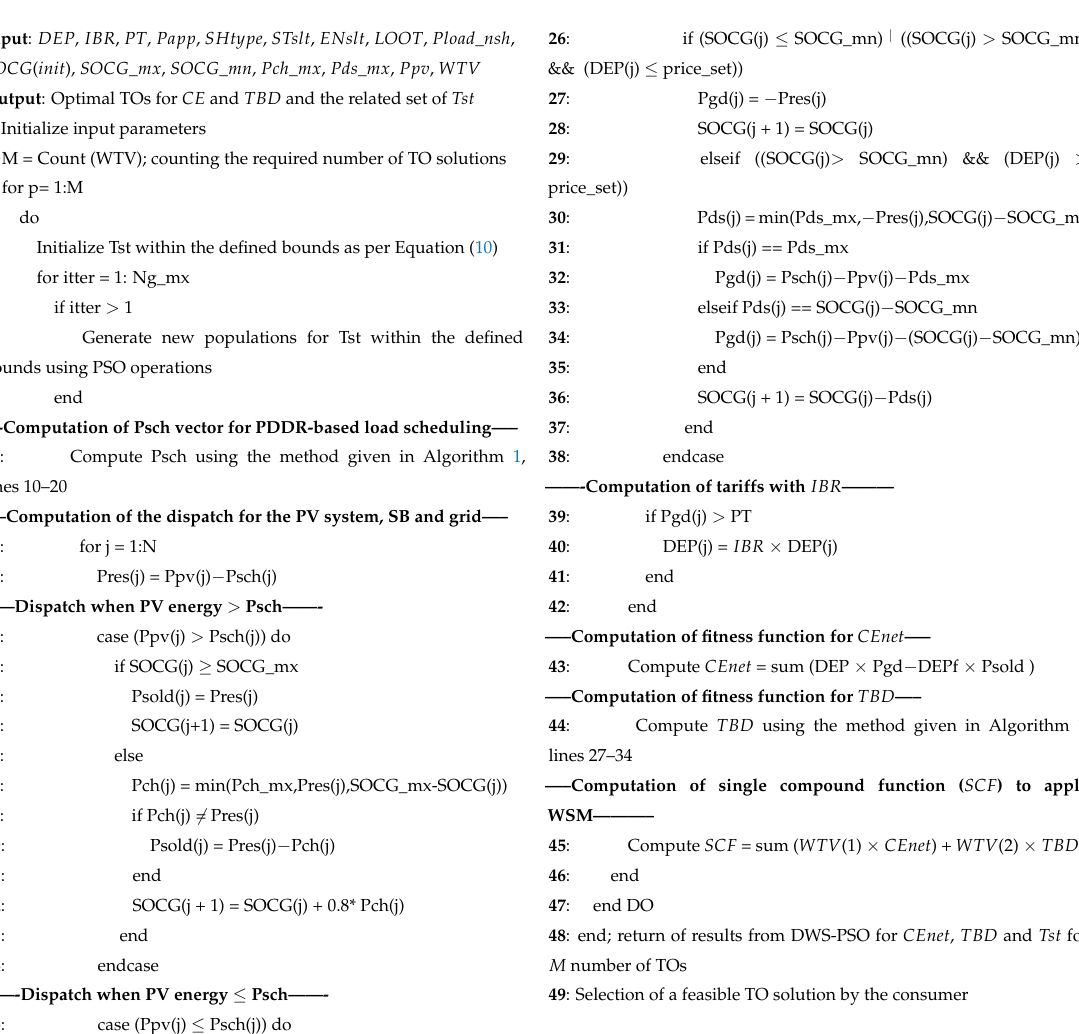
Algorithm 2 Algorithm for a PDDR-RED-based HEMS using